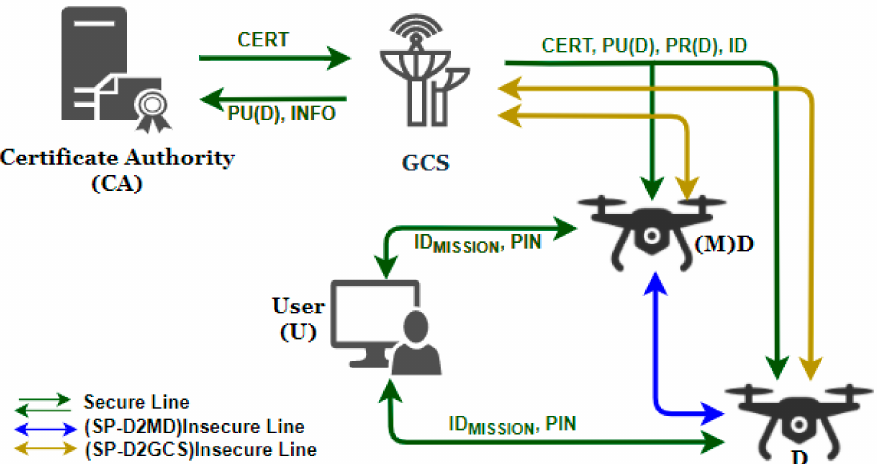
Figure 1. Execution flow of the proposed